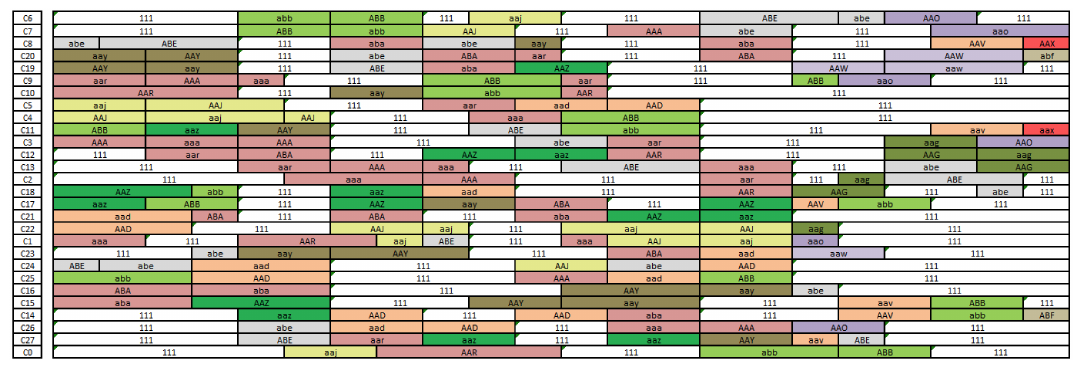
Figure 14. A feasible solution in instance 4.